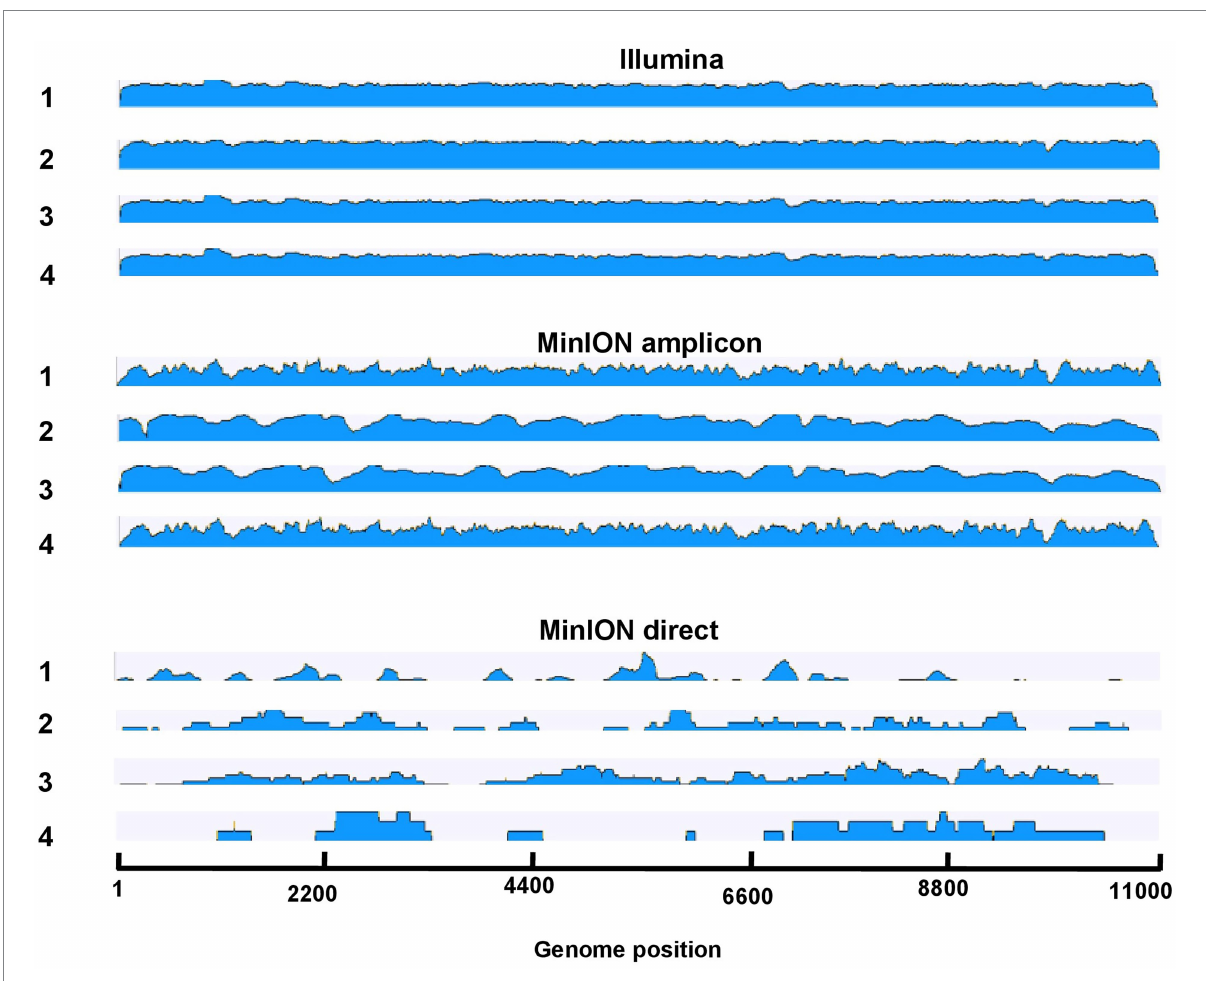
FIGURE 3 Overview of read coverage of sequenced genomes in Illumina, MinION amplicon, and MinION direct in samples 1–4. The scale represents the log transformed coverage depth (min: 10 1 and max: 10 6